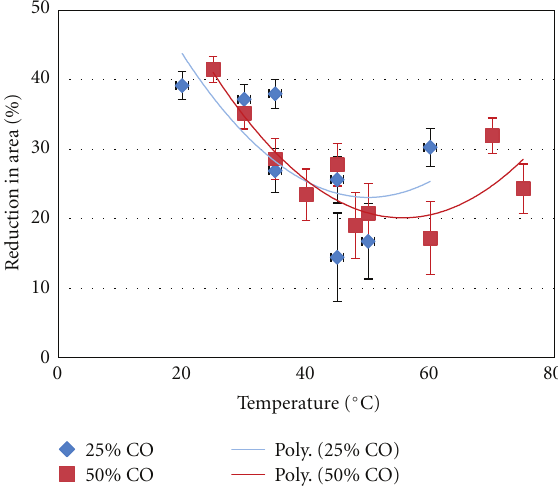
Figure 8: Comparison of results with two di ff erent gas mixtures, 25% CO and the other 50% CO.